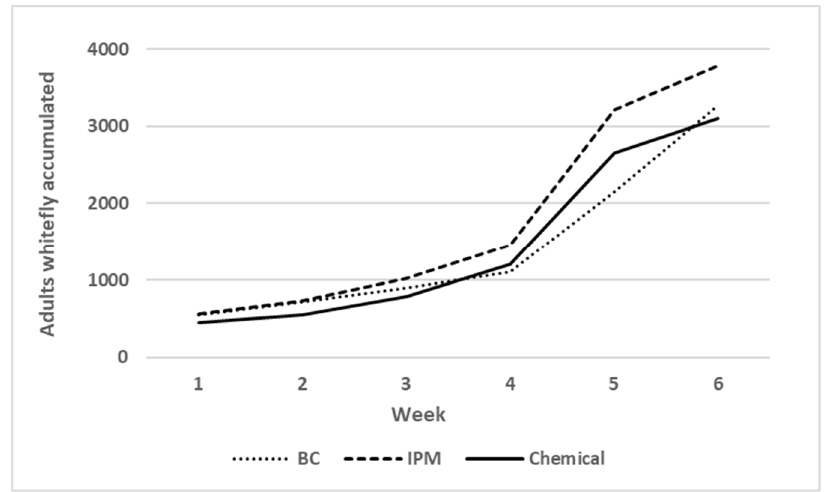
Figure 3 . Accumulated average number of adult whitefly per yellow sticky trap outdoors of the experimental greenhouse compartments.